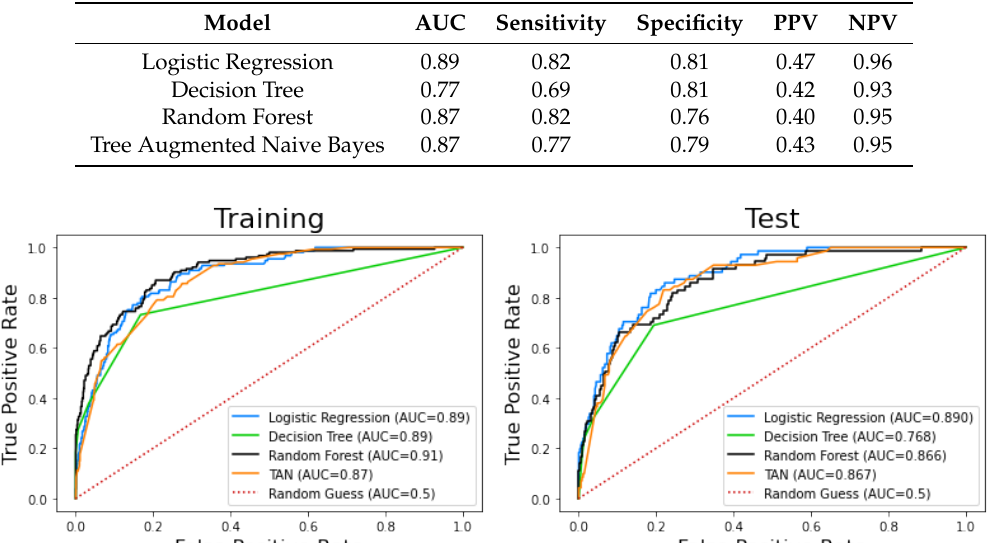
Table 5. Performance of the supervised models on the test set. PPV: Positive Predictive Value. NPV: Negative Predictive Value.